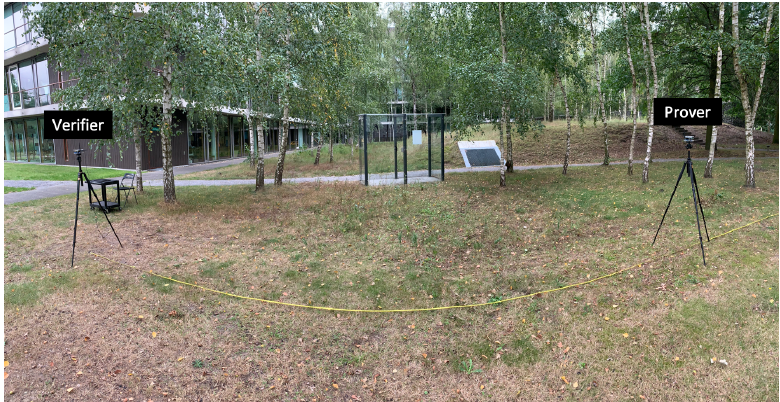
Figure 13: Outdoor wireless measurement